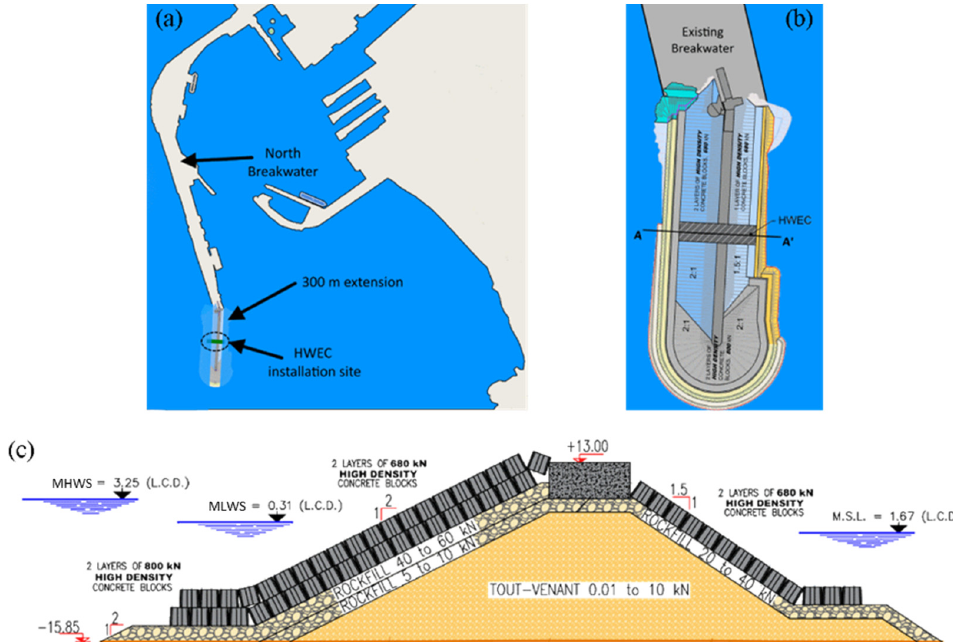
Figure 2. ( a ) General layout of Port of Leix õ es with the breakwater extension and the HWEC; ( b ) provisional layout of the extension of the breakwater; ( c ) cross-section AA’ with the three water levels represented, reproduced with permission from [42]. Copyright 2020, Elsevier (cf. Table